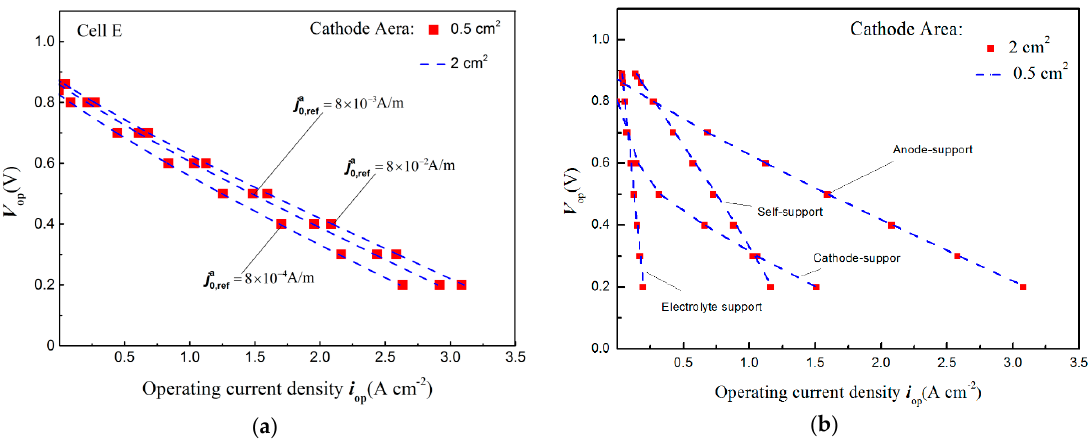
Figure 6. The sensitivity of button cell performances on different A ca /A an : ( a ) Under various exchange current densities, ( b ) while different component support cases are considered.